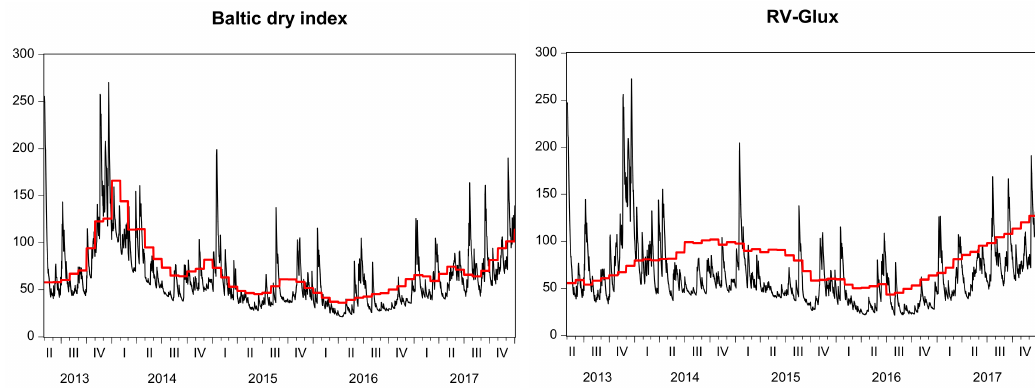
Figure 3. The figure shows the annualized long-term (bold red line) and short-term (black line) volatility components as estimated by the GARCH-MIDAS models with the Baltic dry index ( left ) and the realized volatility of the luxury goods index ( right ) as explanatory variables.